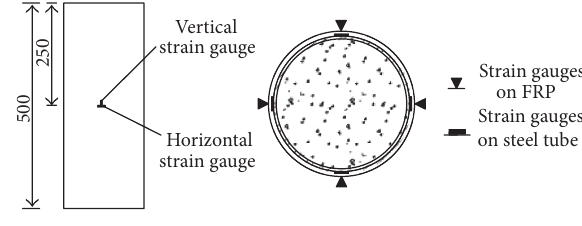
Figure 4: Strain gauges arrangement for specimens.